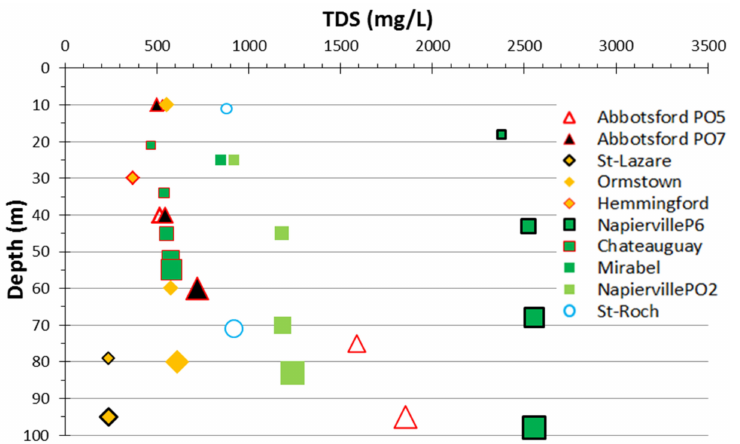
Figure 10. TDS as a function of depth and lithology (red–schist, orange–sandstone, green–dolomite and